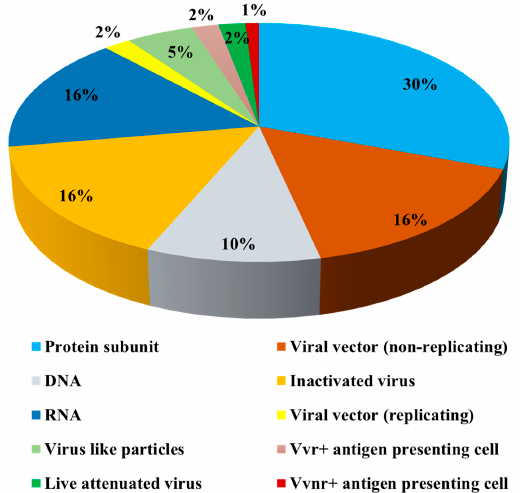
Figure 1. Vaccine platforms used to develop coronavirus disease 2019 (COVID-19) vaccine candidates. Data source: World Health Organization (WHO), June 19, 2021.